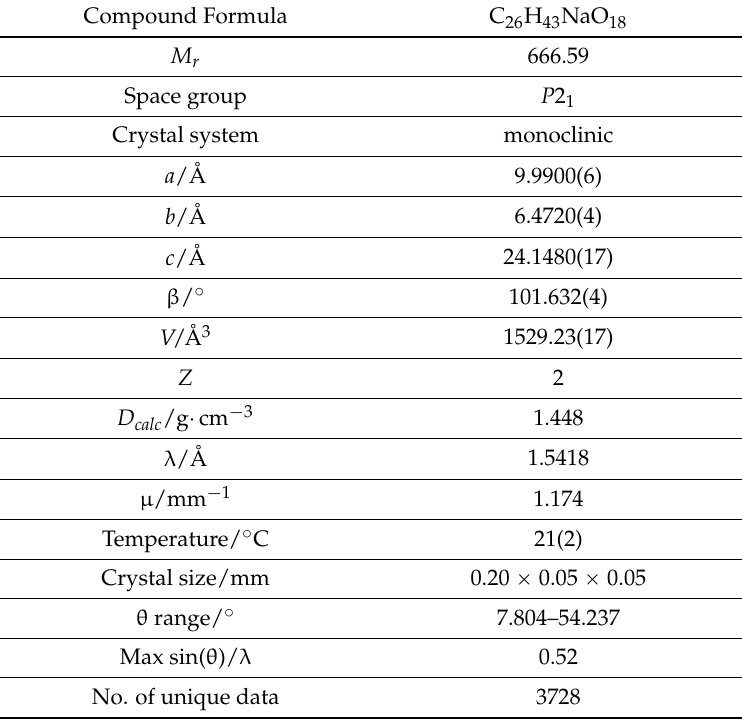
Table 2. Experimental